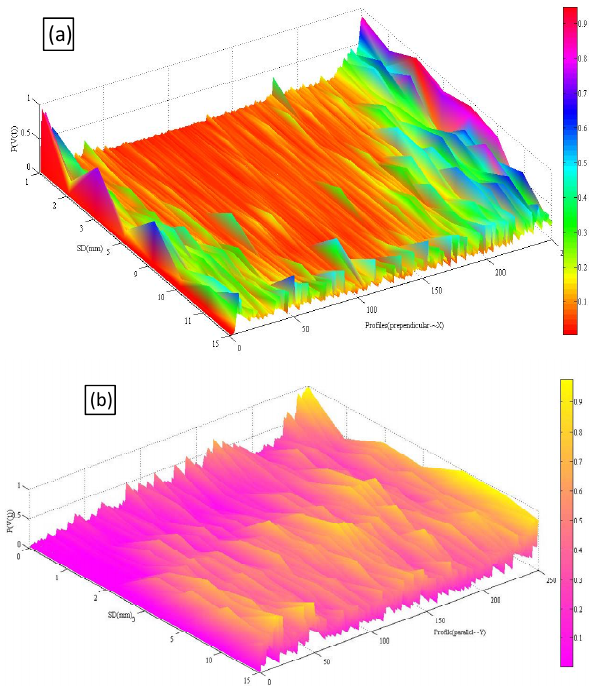
Fig. 7. Evolution of the inverse participation factor for profiles in Figure 7. Evolution of the inverse participation factor for profiles in X and Y directions :a) X and Y directions: (a) perpendicular profiles are localized from perpendicular profiles are localized from boundaries to inside profiles. b) Parallel boundaries to inside profiles. (b) Parallel profiles after interlocking profiles after interlocking of asperities (SD~1mm) are nearly following random of asperities (SD ∼ 1mm) are nearly following random localization. localization.